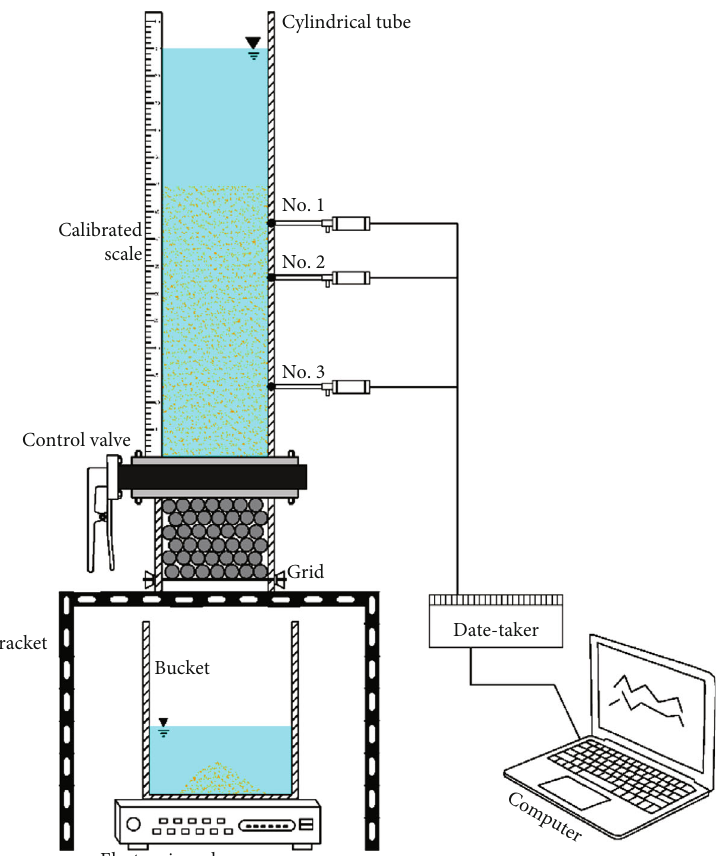
Figure 2: Experimental